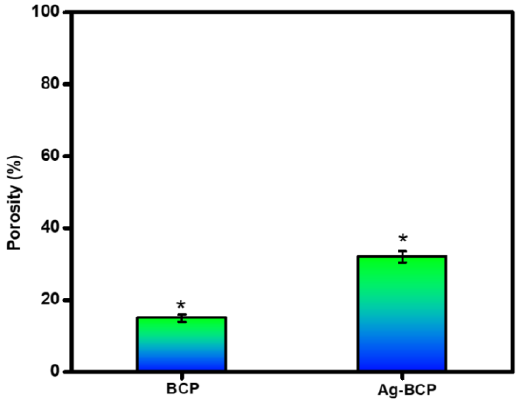
Figure 8. TGA and DTA analysis of BCP and Ag-BCP samples.